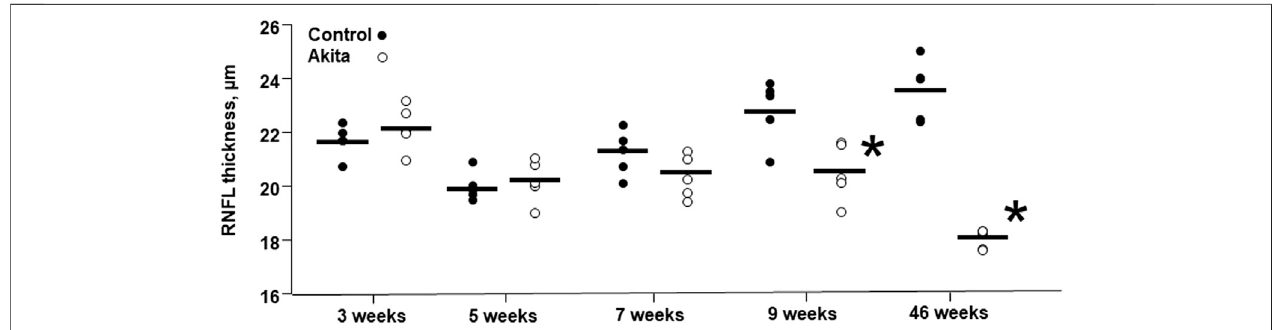
FIGURE 7 | Retinal nerve fi ber layer thickness in wild-type and Ins2 Akita animals. Retinal nerve fi ber layer (RNFL) thickness is expressed in µm and the values are shown as fi lled dots for wild-type mice and open dots for Ins2 Akita animals. * p < 0.05, student t -test vs control wild-type.